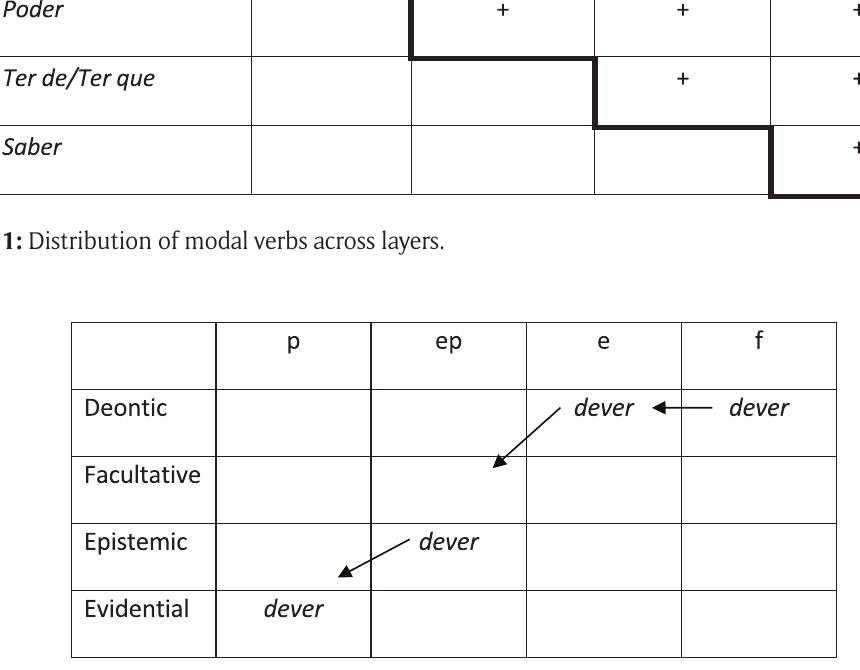
Figure 2: Hypothesized development of